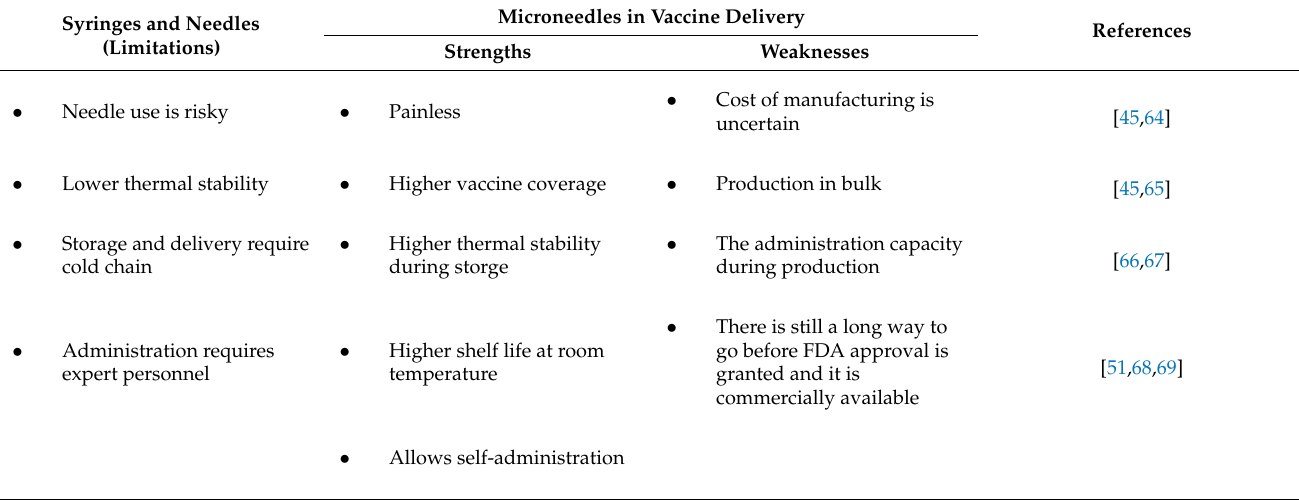
Table 1. Comparison of syringe and MN